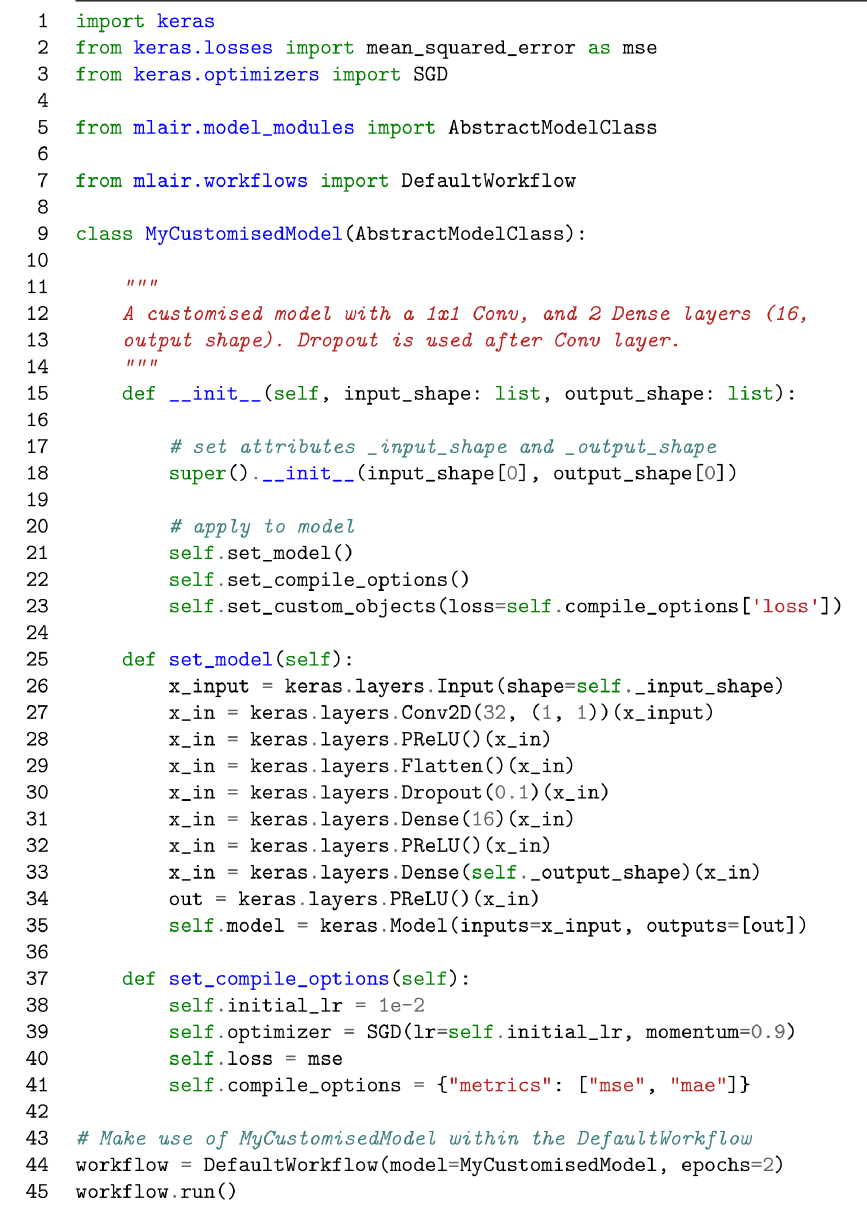
Figure 14. Example how to create a custom ML model implemented as a model class. MyCustomisedModel has a single 1 × 1 convolution layer followed by two fully connected layers with a neuron size of 16, and the number of forecast steps. The model itself is defined in the set_model method, whereas compile options such as the optimizer, loss, and error metrics are defined in set_compile_options . Additionally, for demonstration, the loss is added as custom object which is not required because a Keras built-in function is used as